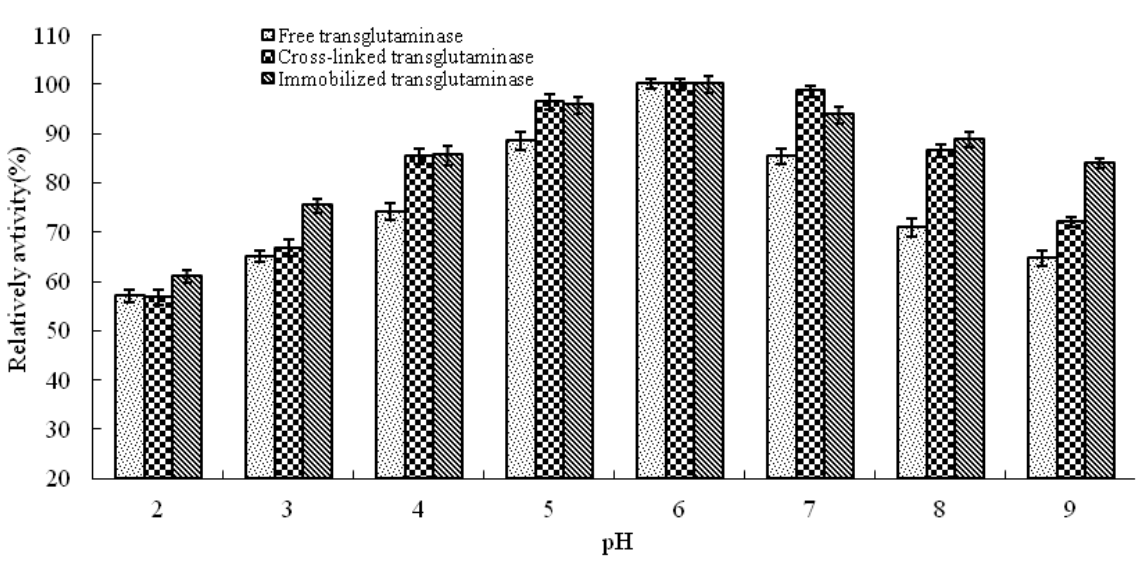
Figure 3. pH profile of free, cross-linked and immobilized transglutaminase. Data are expressed relative to the maximal enzyme